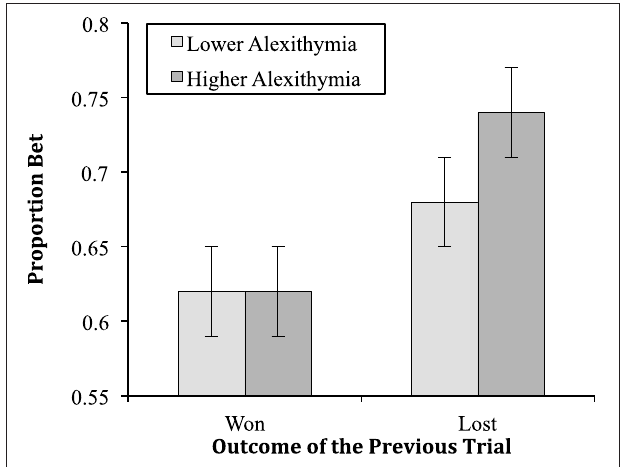
FIGURE 3 | The means (and standard errors) of the proportion bet for the alexithymia groups having won or lost on the previous trial.